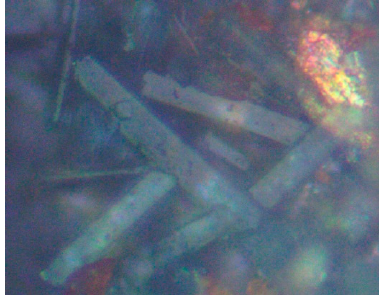
Figure 9. ST Trial Pellet (Trial ST3f [16]) Following Desalination showing a nest of atacamite crystals with the characteristic blue-green internal reflections of Cu 2 (OH) 3 Cl species. The strongly pleochroic golden grain is tenorite (CuO). Thickness = 2 microns; width = 14 microns; length = 25–110 microns. Reflected Light; Field of view = 0.133 mm.